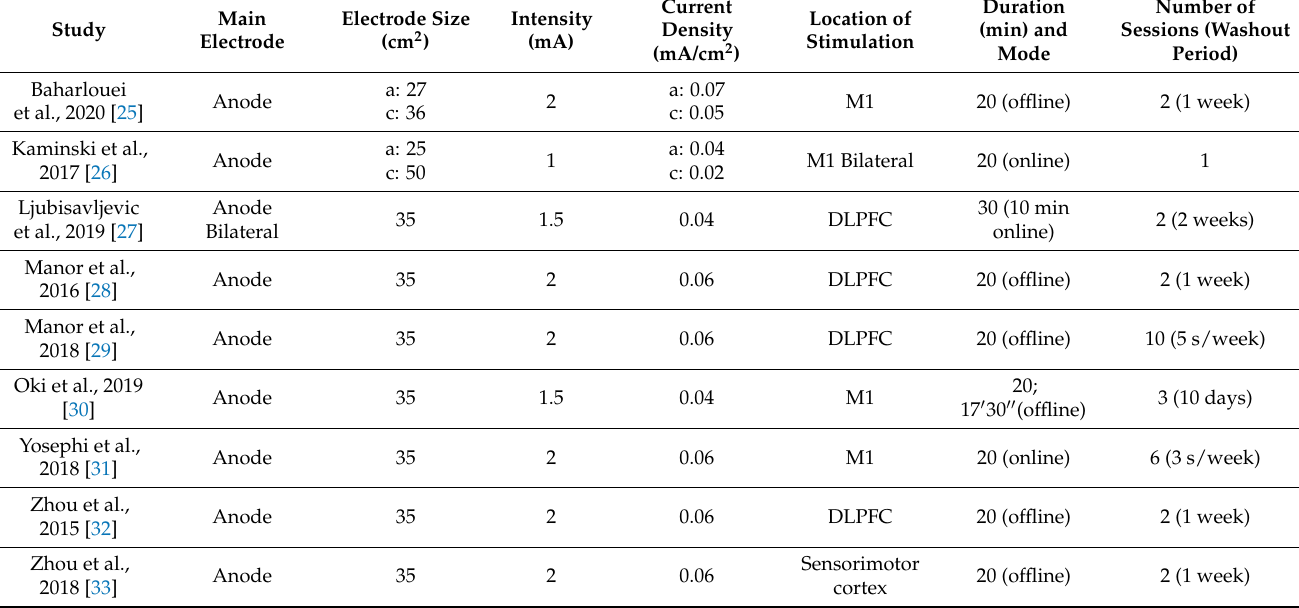
Table 2. Characteristics of transcranial direct current stimulation